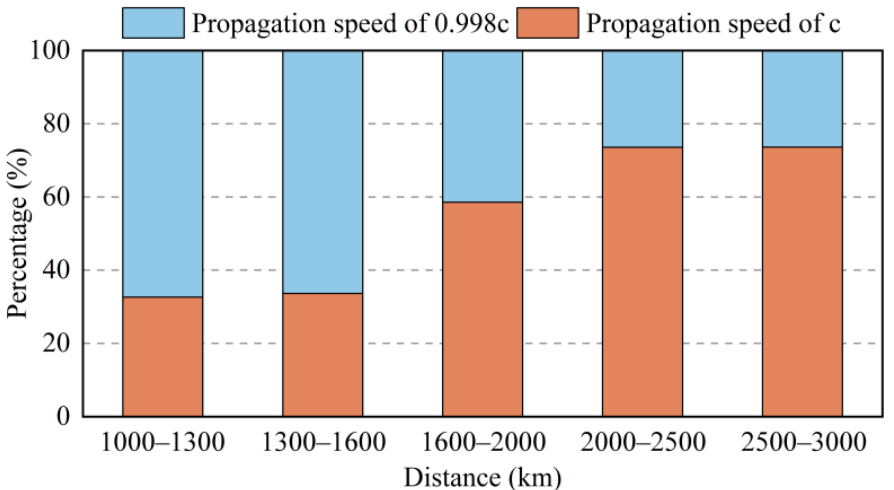
Figure 15. Percentage of the propagation speed that results in less deviation.